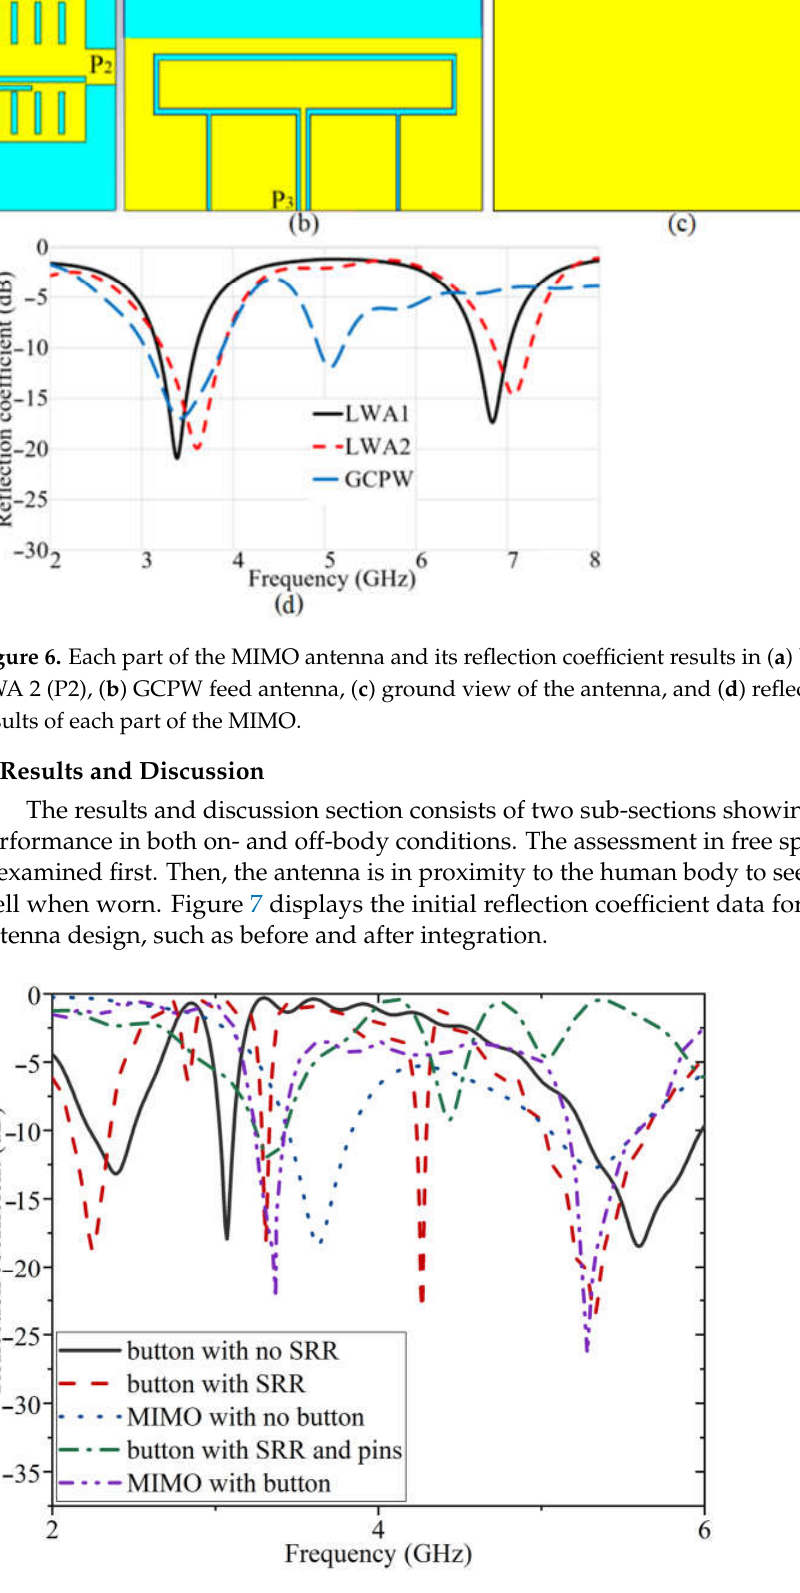
Figure 5. The surface current distribution of the LWA antenna (a: at 3.4 GHz, b: at 5.6 GHz).